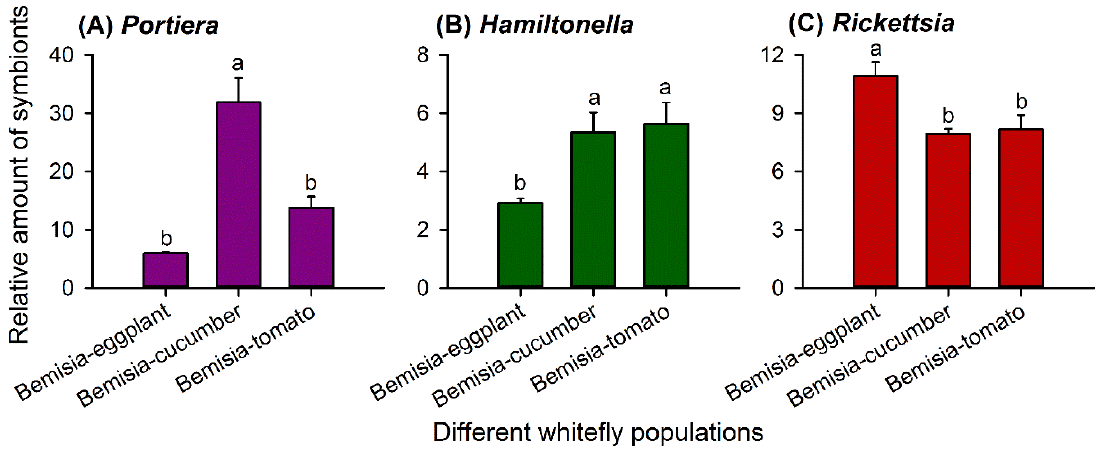
Figure 2. Relative abundance of Portiera ( A ), Hamiltonella ( B ), and Rickettsia ( C ) (mean ± SE) in whitefly populations G0 of Bemisia -eggplants, Bemisia -cucumbers, and Bemisia -tomatoes. The relative amount of each symbiont taxon was normalized using β -actin and calculated by the 2 - ∆ C t method. Statistical analyses were carried out separately for each symbiont taxon; di ff erent letters above the error bars indicate significant di ff erences for that taxon among the three whitefly populations ( p < 0.05, Tukey’s honest significant di ff erence (HSD) test).